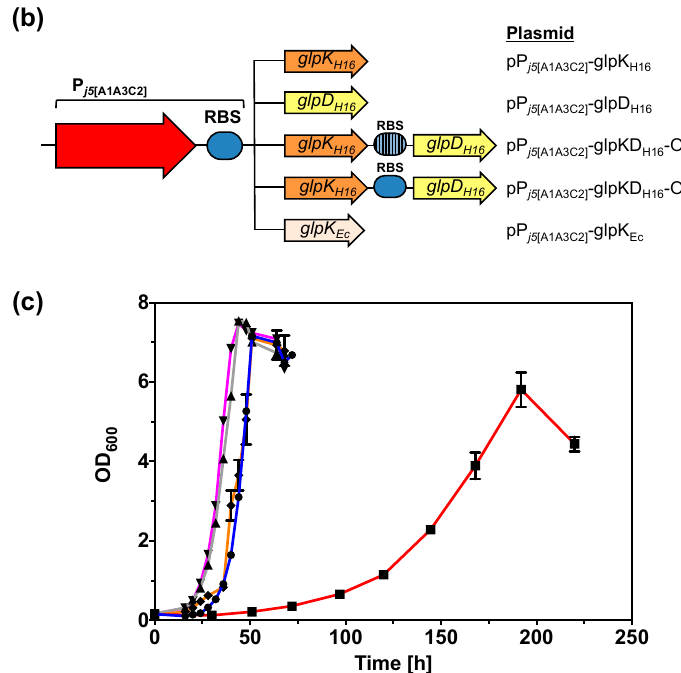
Figure 7. ( a ) General plasmid construct used for cloning of mutated genes identified from genome sequencing. ( b ) Various promoter and gene combinations of glpK and glpD used in this work. ( c ) Growth curves of C. necator H16 harboring glpK H16 , glpKD H16 , and glpK Ec plasmids when cultivated in 0.50% ( w / v ) glycerol; no plasmid (red line; square), pP j5 [A1A3C2] -glpK H16 (orange line; diamond), pP j5 [A1A3C2] -glpKD H16 -O1 (grey line; triangle), pP j5 [A1A3C2] -glpKD H16 -O2 (pink line, inverted triangle), and pP j5 [A1A3C2] -glpK Ec (blue line; circle)